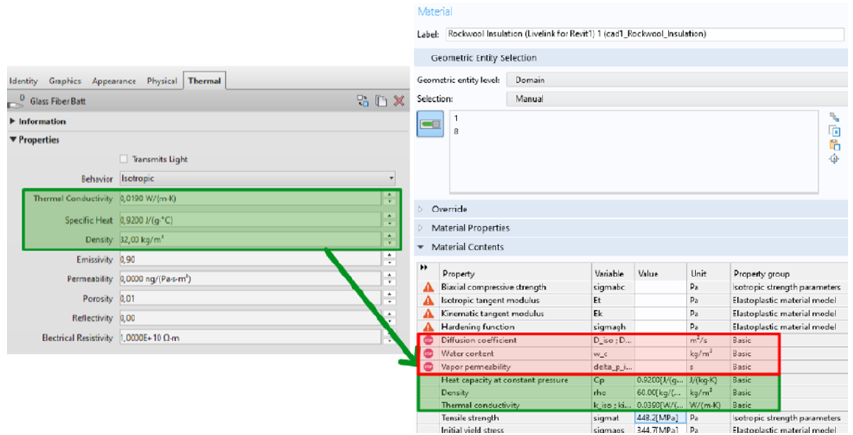
Figure 4. Building material properties transferred from Revit to